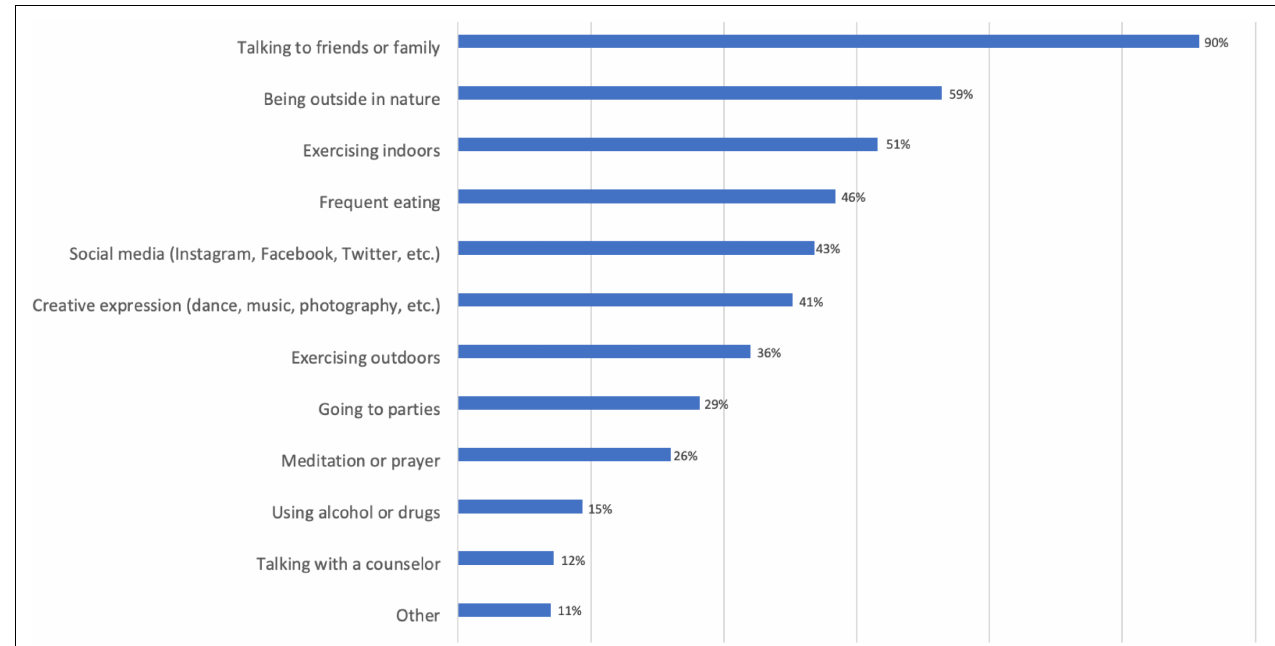
FIGURE 3 | Stress relief strategies and activities